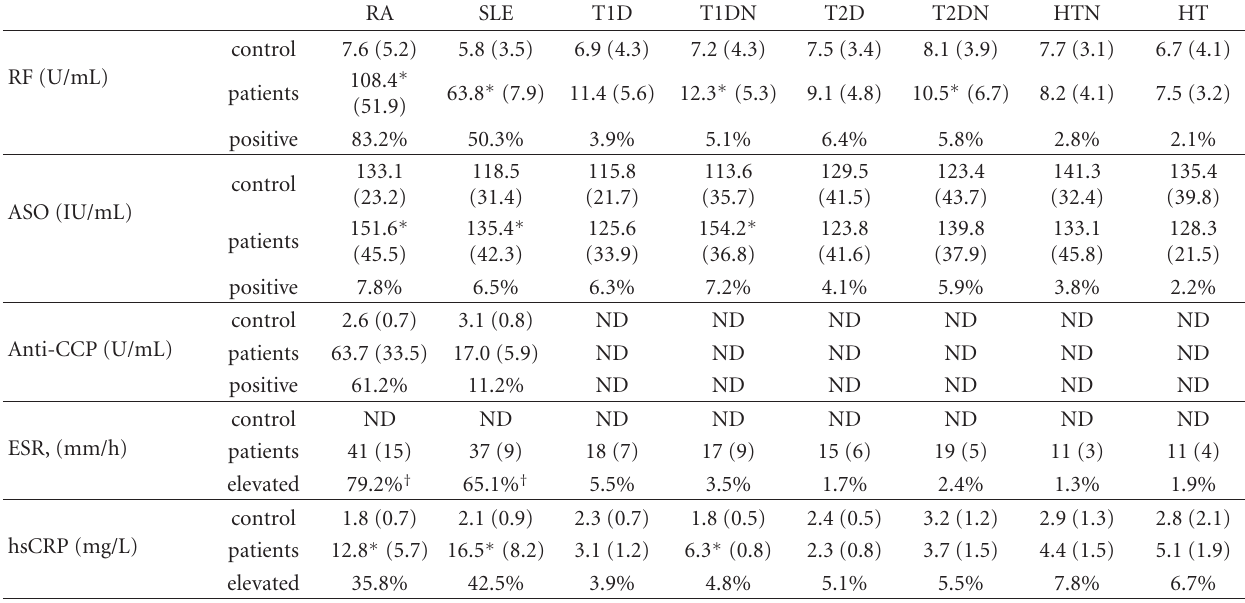
Table 2: The disease indicators of subjects (mean (SD)).